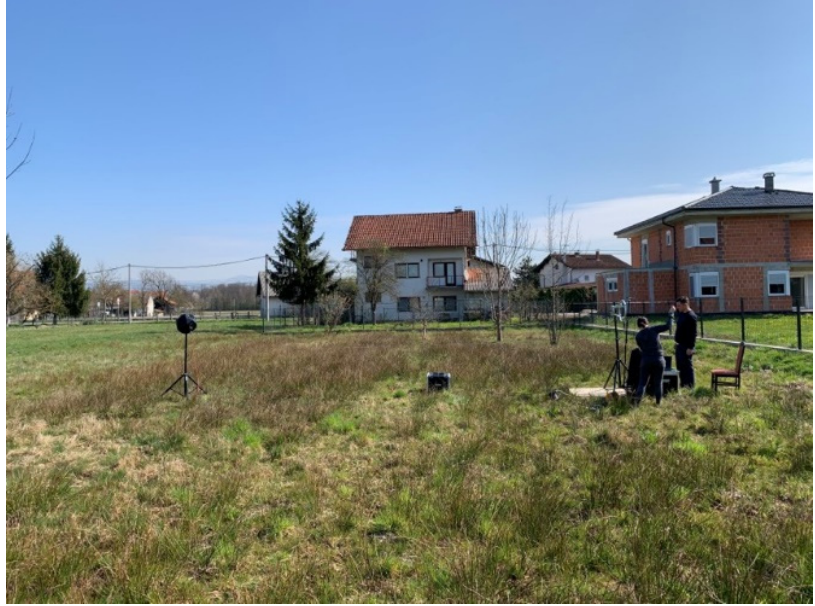
Figure 13. The acoustic camera prototype placement during the measurement.